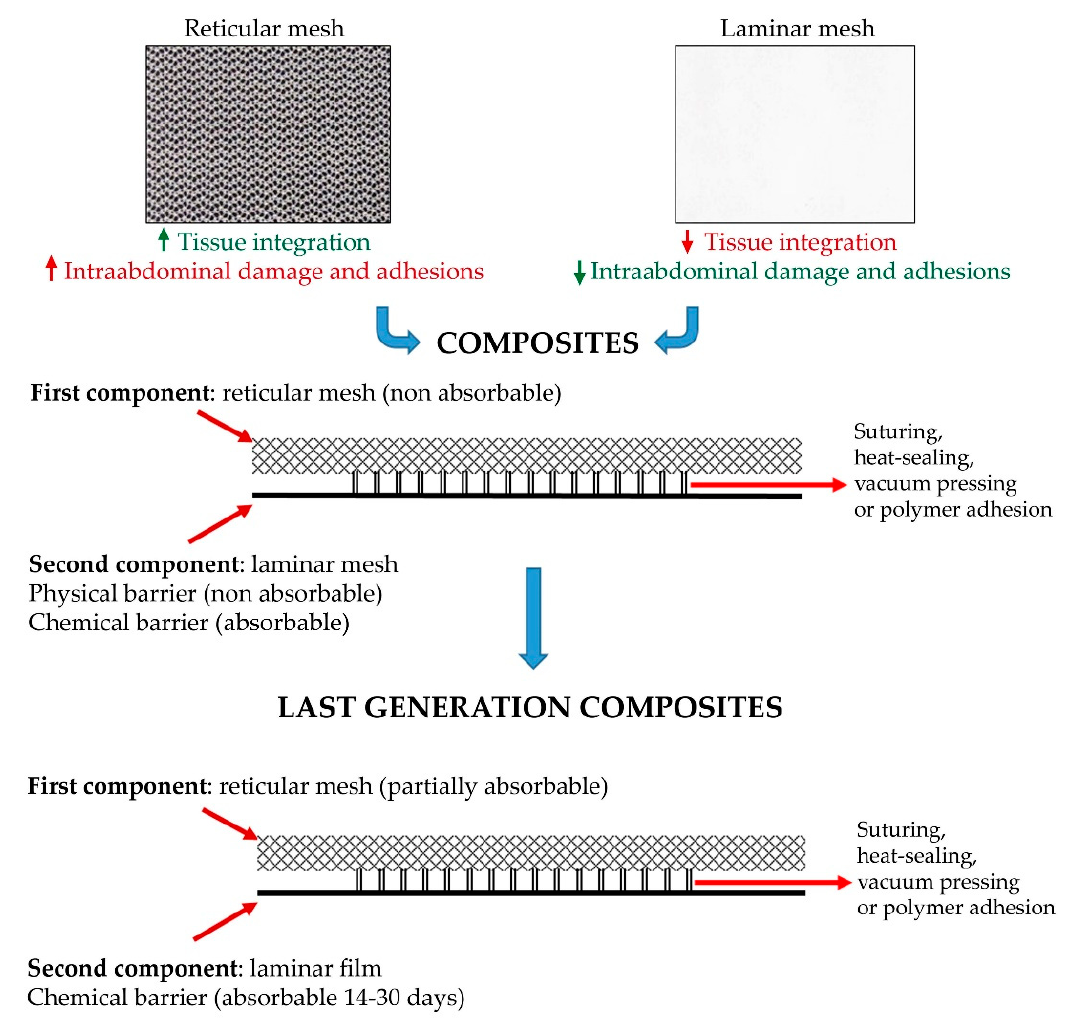
Figure 5. Composites consist of the combination of two different components linked together by suturing, heat-sealing, vacuum pressing or polymer adhesion.